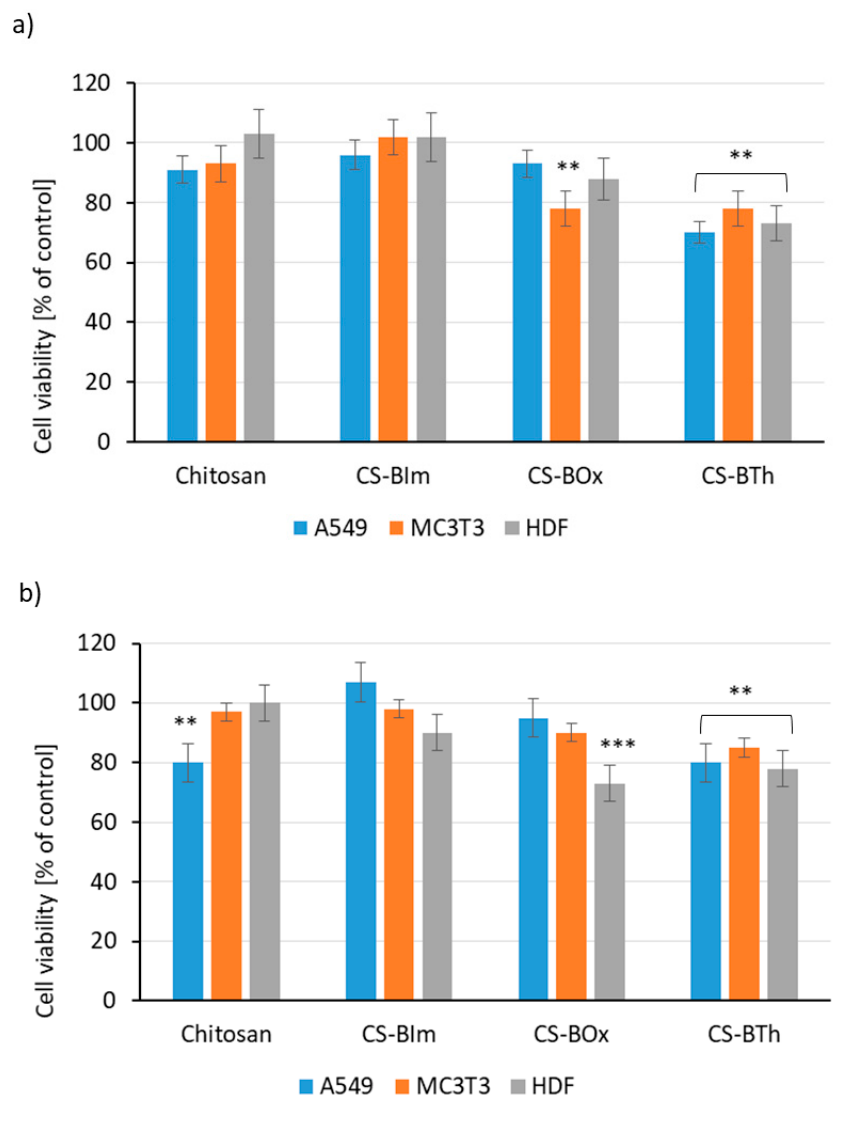
Figure 8. Results of MTT assay ( a ) and NRU test ( b ) for lung epithelial cells (A549), osteoblastic cells (MC3T3) and dermal fibroblasts (HDF). The data are presented as mean ± SD. The statistical significance of the differences is related to control samples and marked on the graphs with asterisks (** for p ≤ 0.01, *** for p ≤ 0.001).